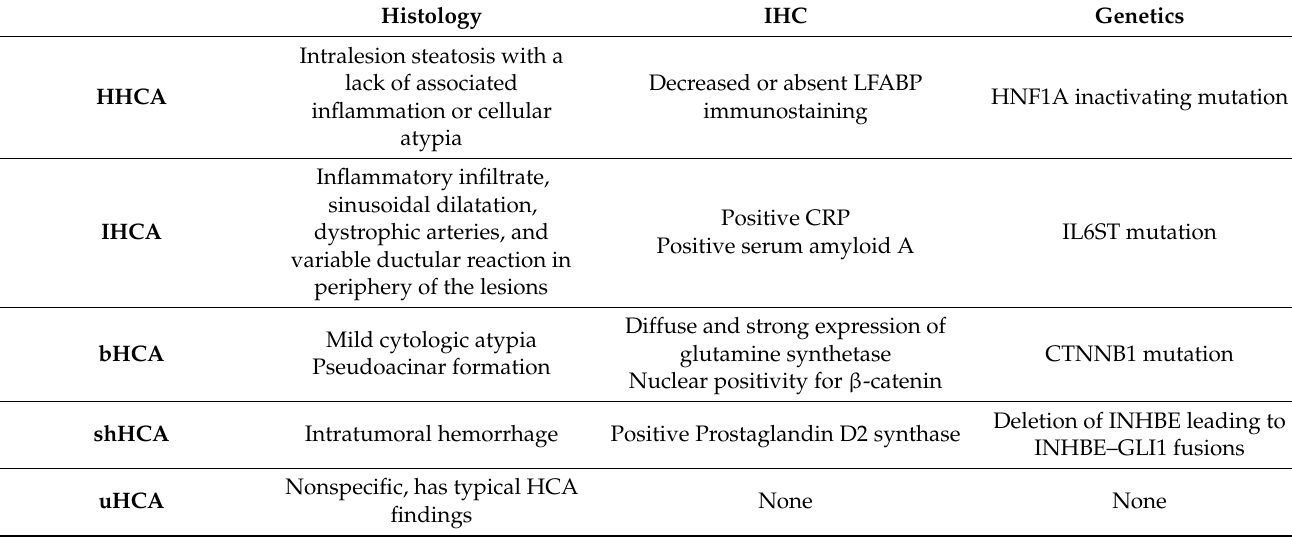
Table 3. Hepatocellular Adenomas (HCA): Histology, Immunohistochemistry, and Genetic